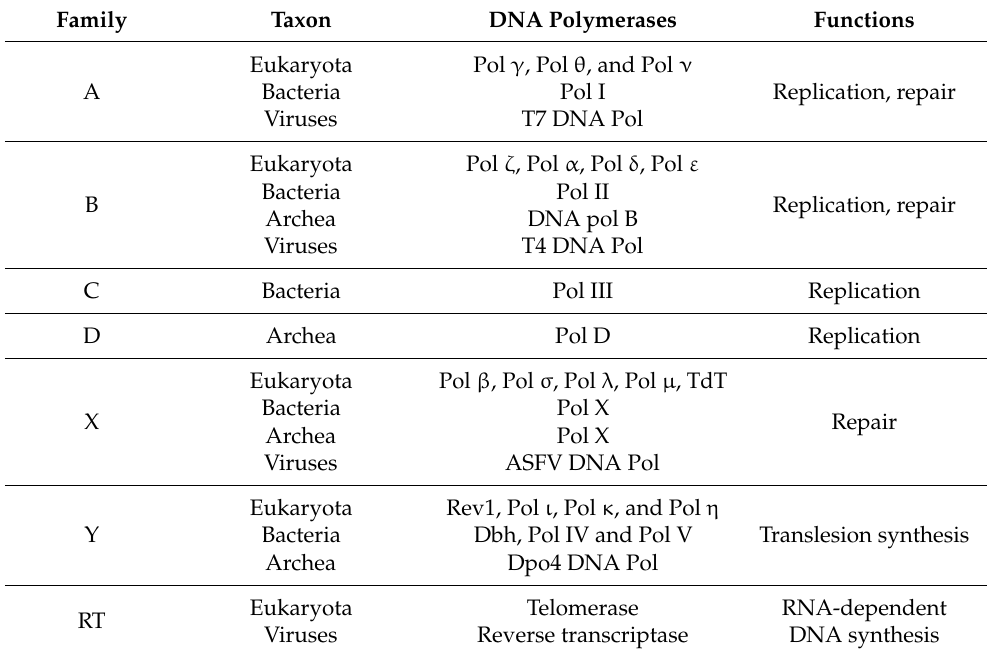
Table 1. Families of DNA polymerases